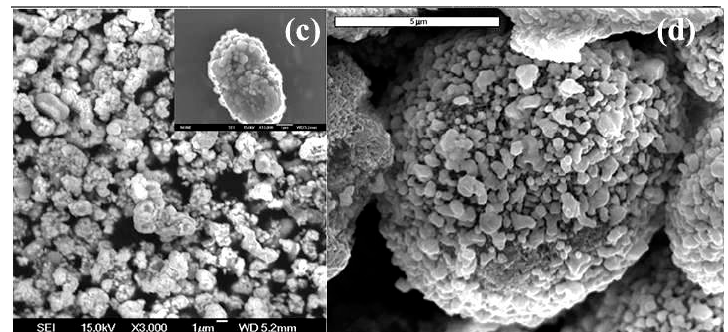
Figure 4. SEM micrographs of ( a ) pristine Al 2 O 3 powder and Cu-coated Al 2 O 3 ( b ) in this work; ( c ) in Wang et al. [25]; and ( d ) Ag coated onto polyimide [26].